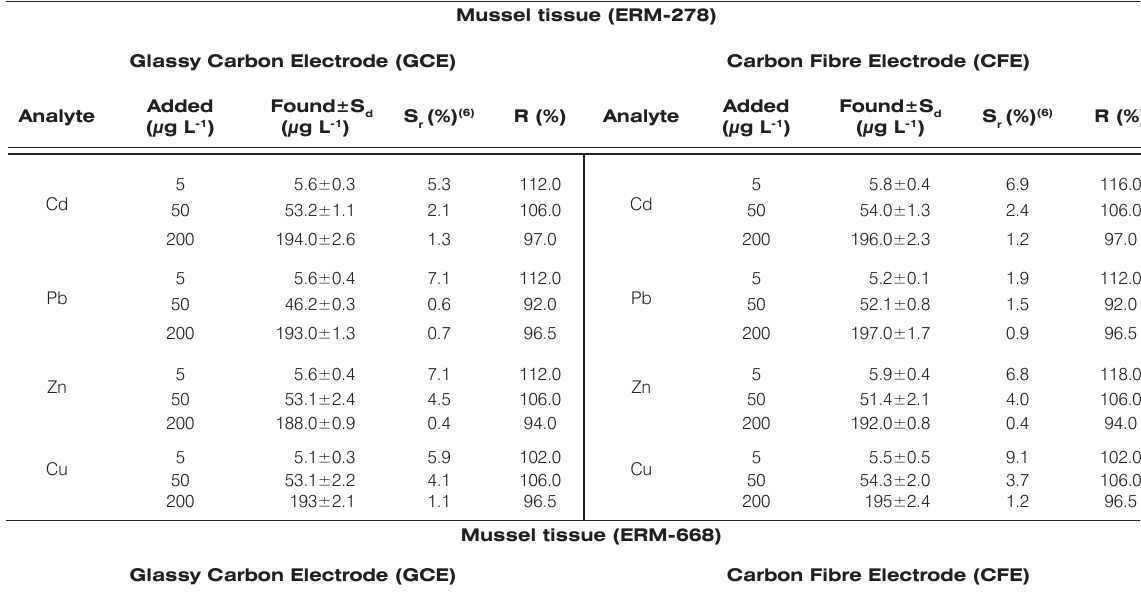
Table 4. Precision and recovery in zinc, cadmium, lead and copper determinations in mussel tissue certified reference materials